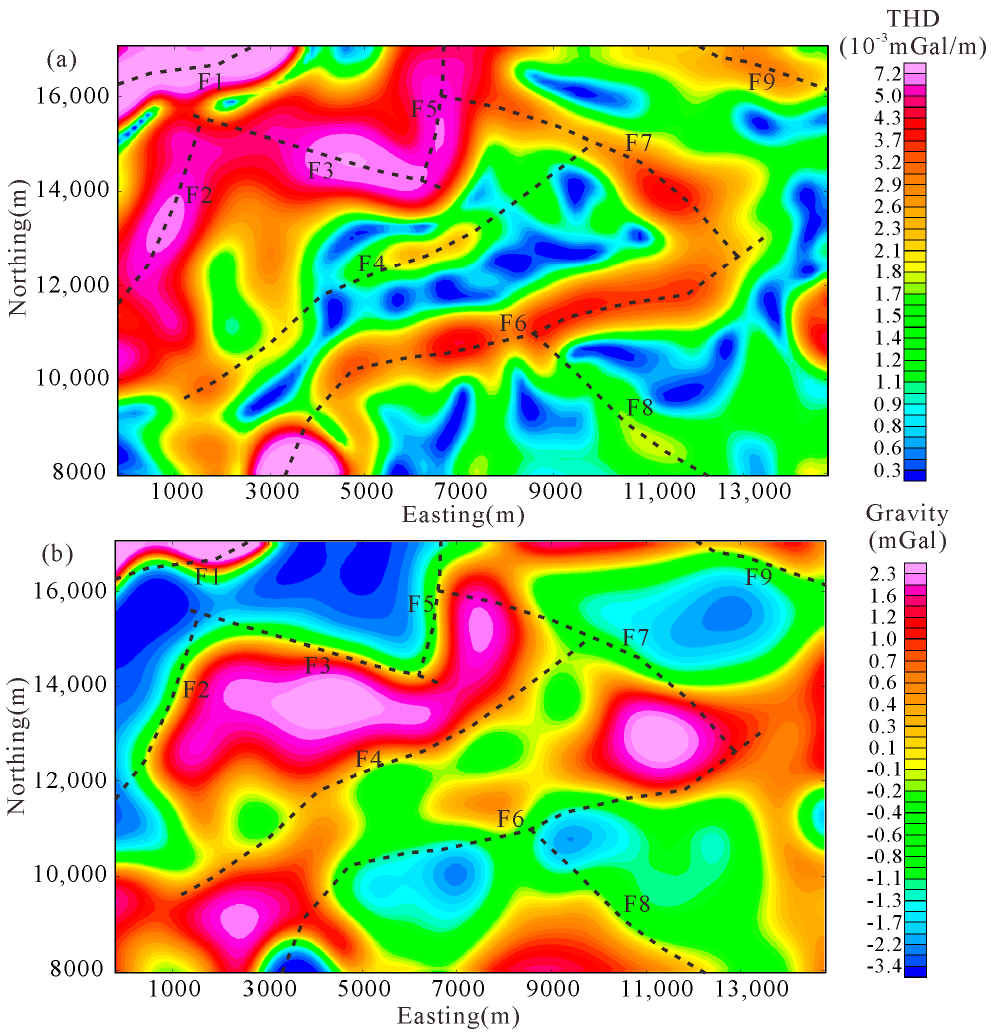
Figure 7. Fracture interpretation results on total horizontal derivative and local gravity field; the dashed lines F1–F9 represent the faults interpreted by the total horizontal derivative. ( a ) Total horizontal derivative; ( b ) field of local gravity anomaly.